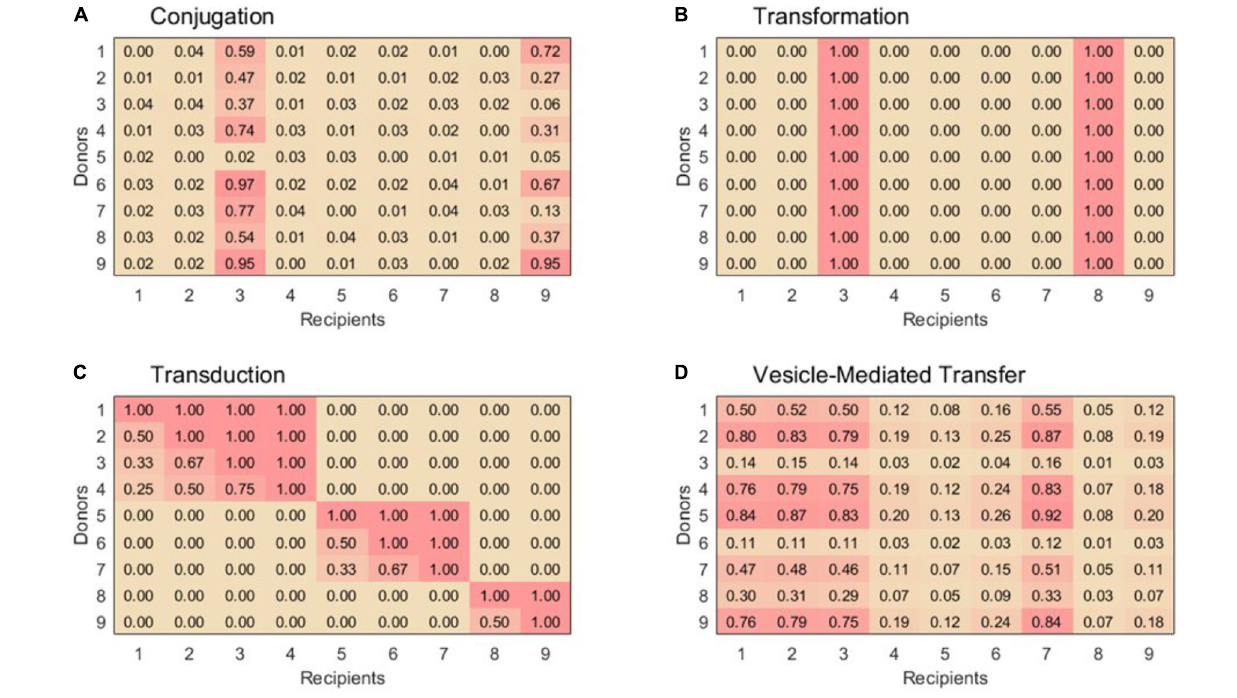
FIGURE 1 | Example 9 × 9 compatibility matrices, α , for each horizontal gene transfer mechanism. (A) For conjugation, species 3 and 9 are part of the super-permissive core. (B) For transformation, only selected species can be recipient strains. Species 3 and 8 are naturally transformable whereas the other species are unable to uptake free DNA. (C) Transduction displays nested sets of species that are able to exchange phages. Within set of species that exchange phages, species with the highest exchange rates can be infected by all the phages in that module, while others with low exchange rates can only be infected by generalist phages. (D) Vesicle-mediated transfer has variable exchange rates, although as in conjugation all species are able to act as donors and recipients. Example matrices were chosen to emphasize key features for each transfer mechanism, see text for construction of matrices used in